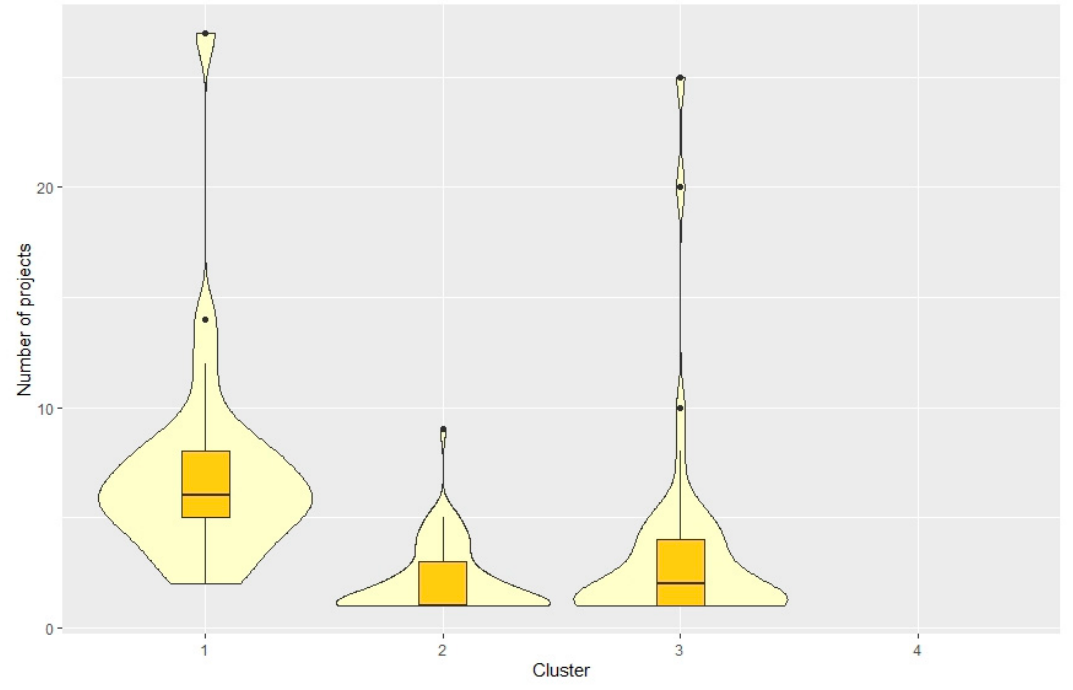
Figure A4. Violin plots for number of solar projects in clusters, cluster 4–no projects.